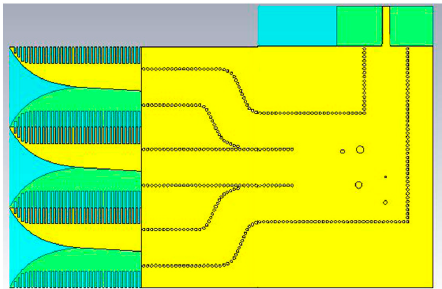
Figure 15. Vivaldi antenna array with three-way in-phase SIW power divider feed system.